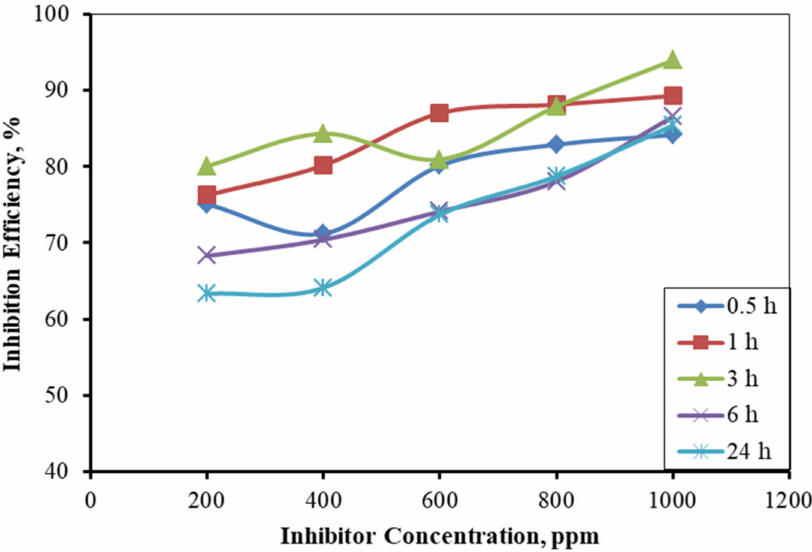
Figure 6. Inhibition efficiencies at different concentrations of the inhibitor on mild steel in the 1 M H 2 SO 4 solution for various